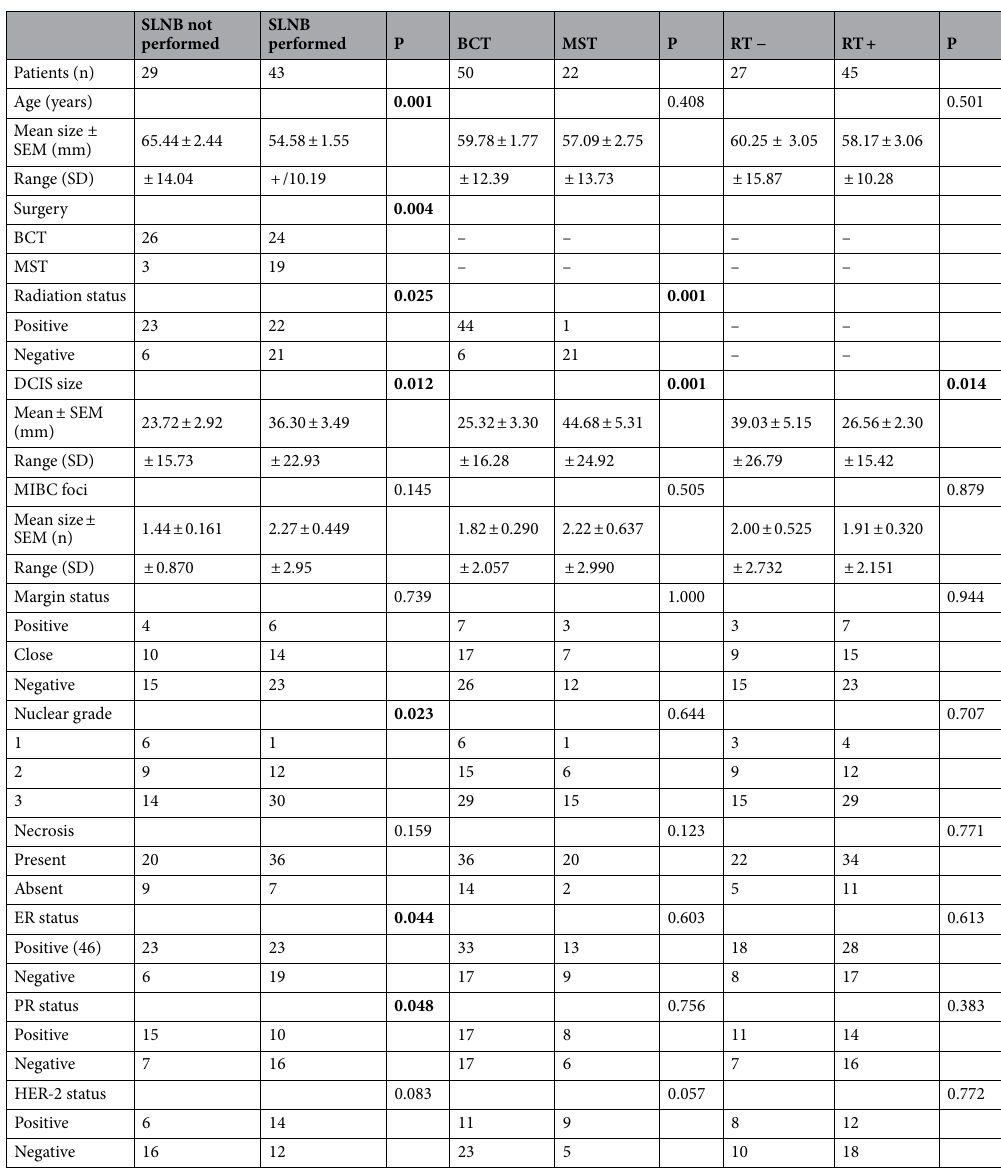
Table 1. Patient characteristics and pathology findings based on treatment in microinvasive breast cancer. SLNB sentinel lymph node biopsy, BCT breast conservative therapy, MST mastectomy, RT radiation therapy, SEM standard error of the mean, SD standard deviation. The bold indicated statistical